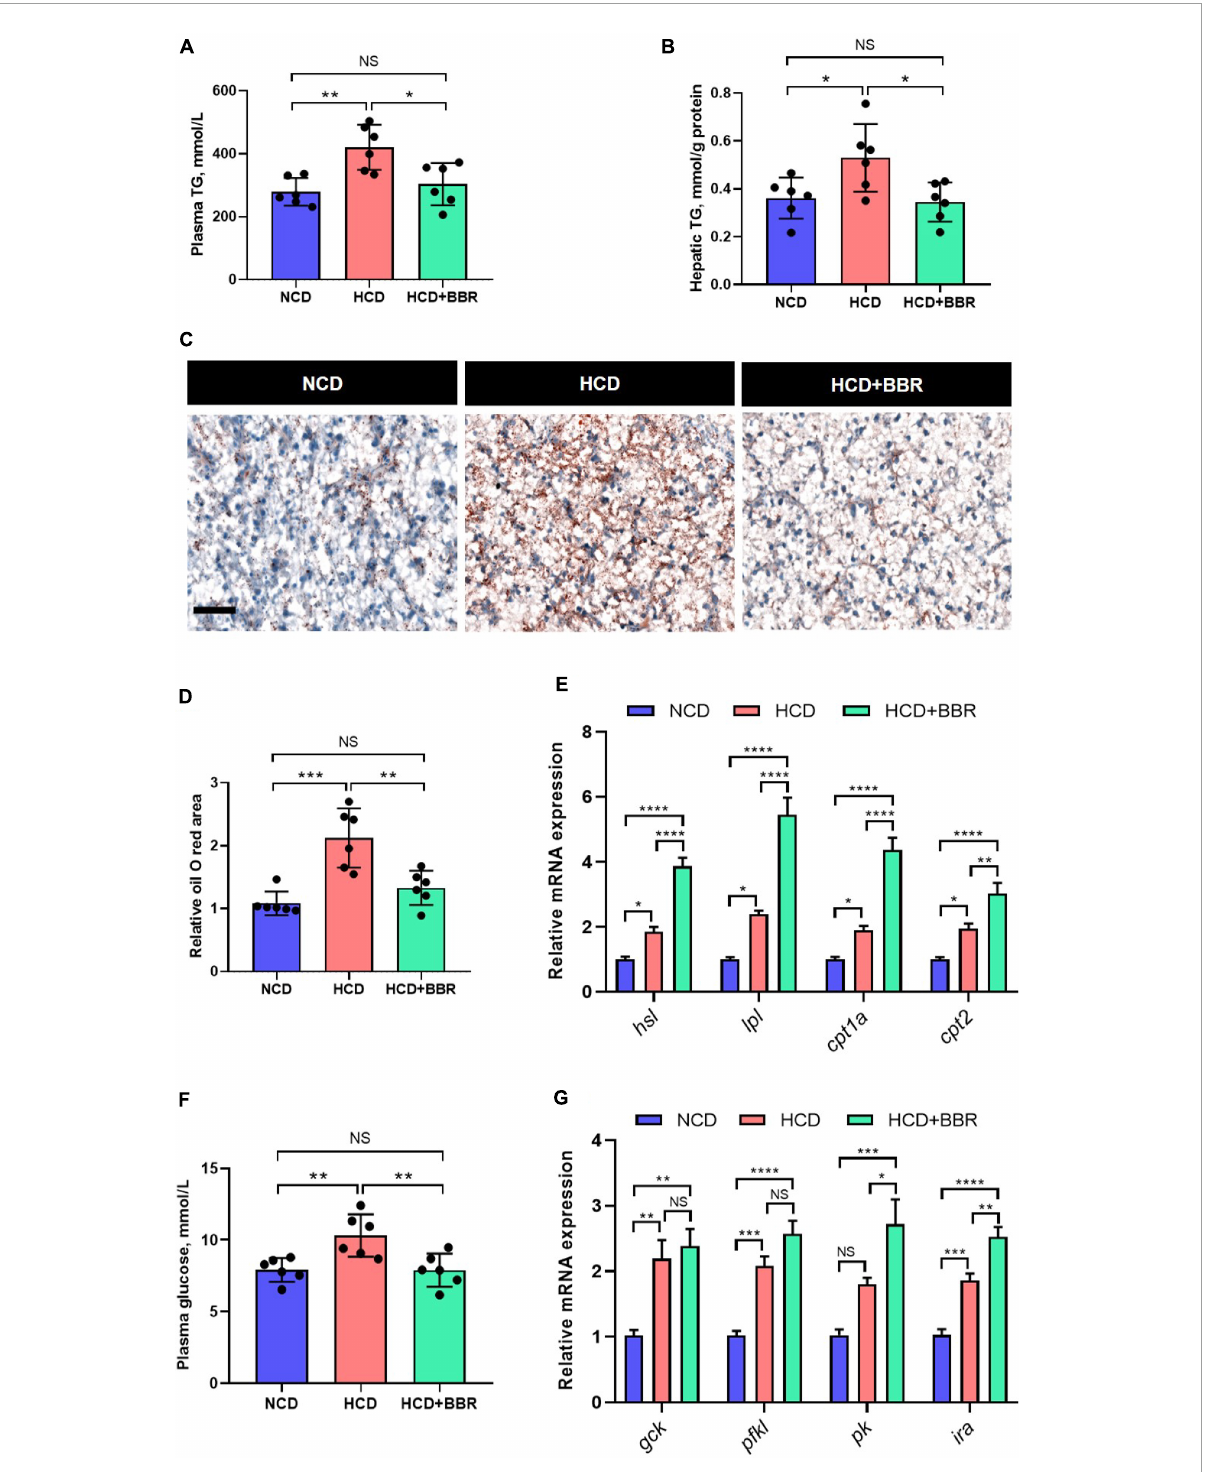
FIGURE6 Dietary BBR promoted the lipid catabolism and glycolysis in the liver of largemouth bass fed with HCD. (A) Plasma TG level. (B) Hepatic TG level. (C) Oil Red O staining images of liver sections (bar = 50 µ m). (D) Relative oil Red O area in liver sections. (E) Expression level of hepatic lipolysis and fatty acid oxidation genes. (F) Plasma glucose level. (G) Expression level of hepatic glycolysis genes. Data are represented as means ± SEM ( n = 6). *, **, ***, ****Different from each other: * P < 0.05, ** P < 0.01, *** P < 0.001, **** P < 0.0001, NS means no significant difference (One-way ANOVA, Duncan’s post hoc